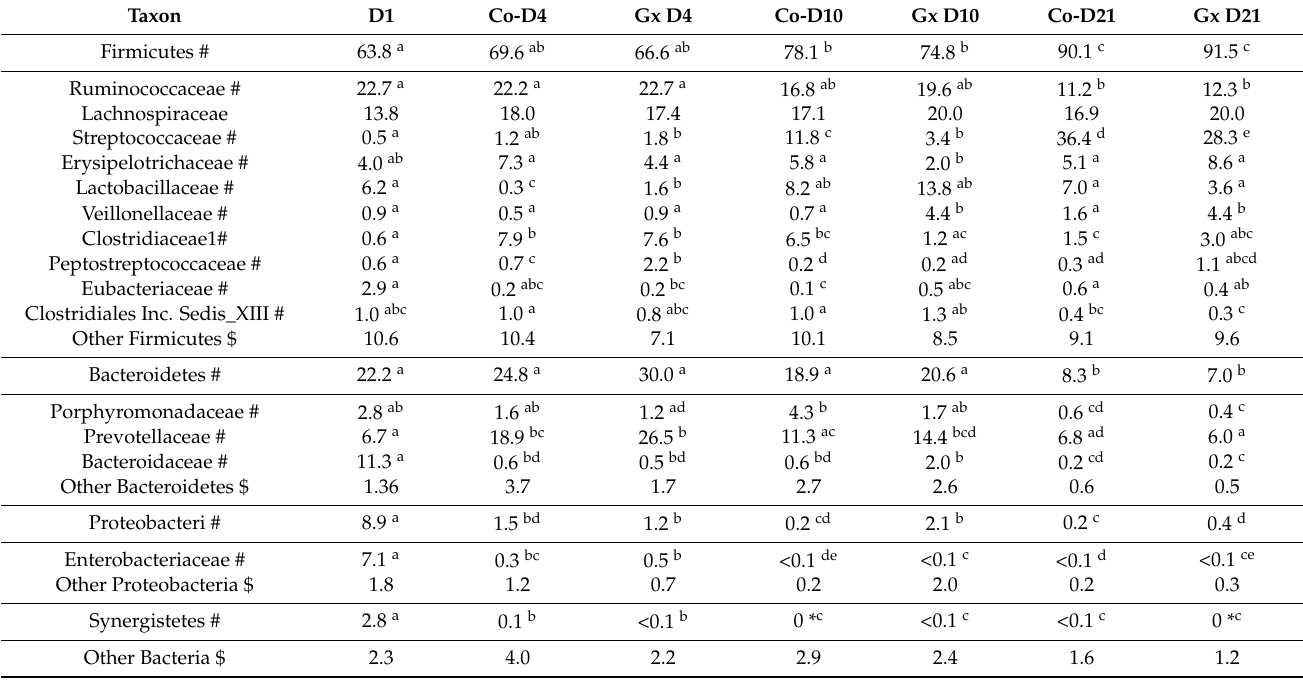
Figure 1. Taxonomic profile at the phylum and family level of fecal bacterial communities of weaned pigs supplemented (Gx) or non-supplemented (Co) with phytoextracts. Families belonging to the same phylum are represented by different shades of the same color: Firmicutes (blue), Bacteroidetes (green), and Proteobacteria (red). Table 1. Mean relative abundance (%) of main bacterial groups in control (Co) and treatment (Gx)